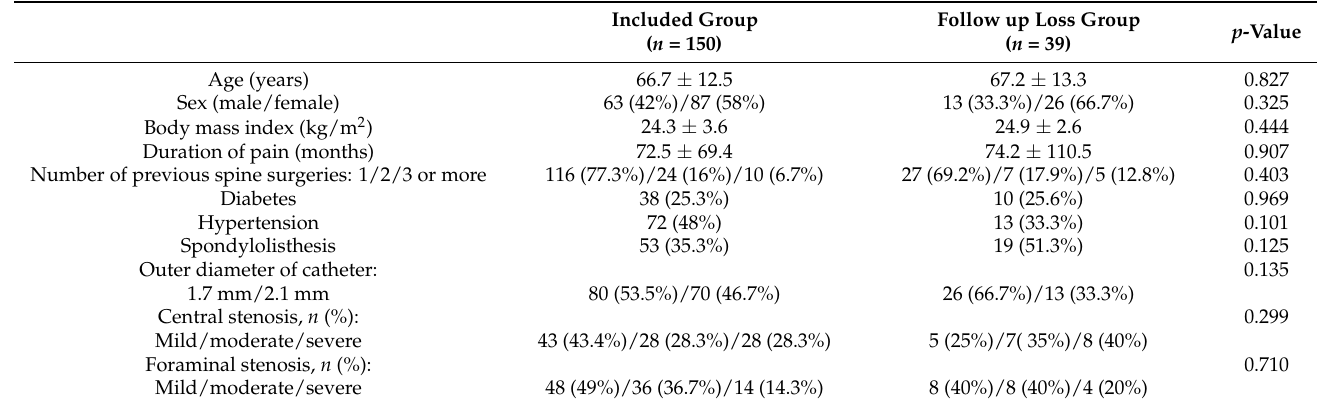
Table 2. Baseline analysis.